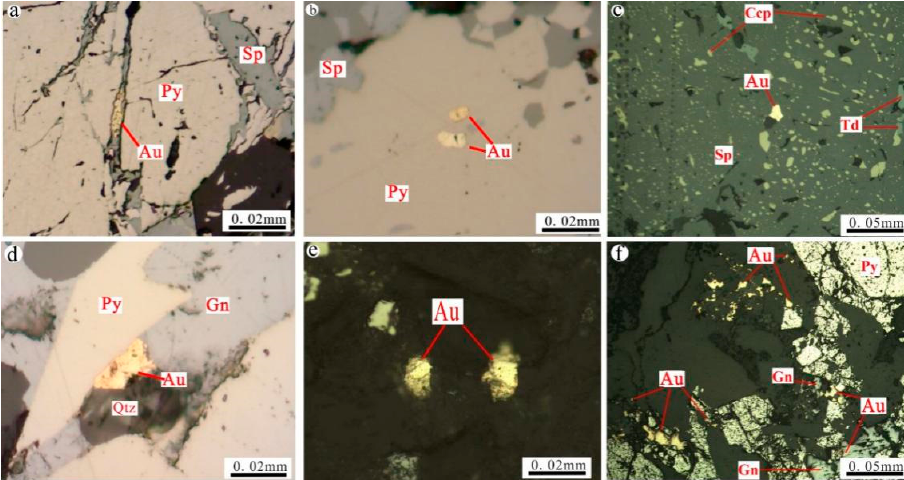
Table 2. Grain size distribution of the gold minerals.